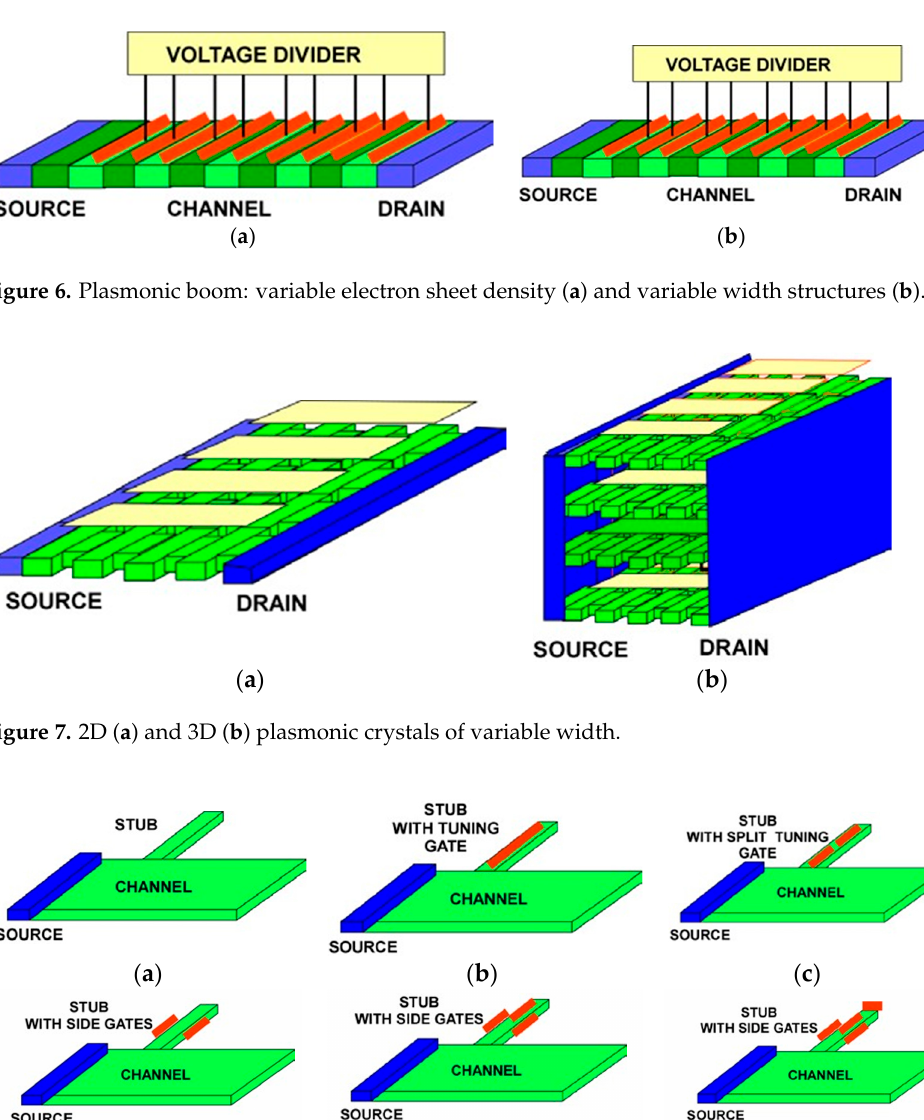
Figure 5. The Dyakonov–Shur (DS) instability increment ( a ) and 1D plasmonic crystal implemen- tation ( b ).